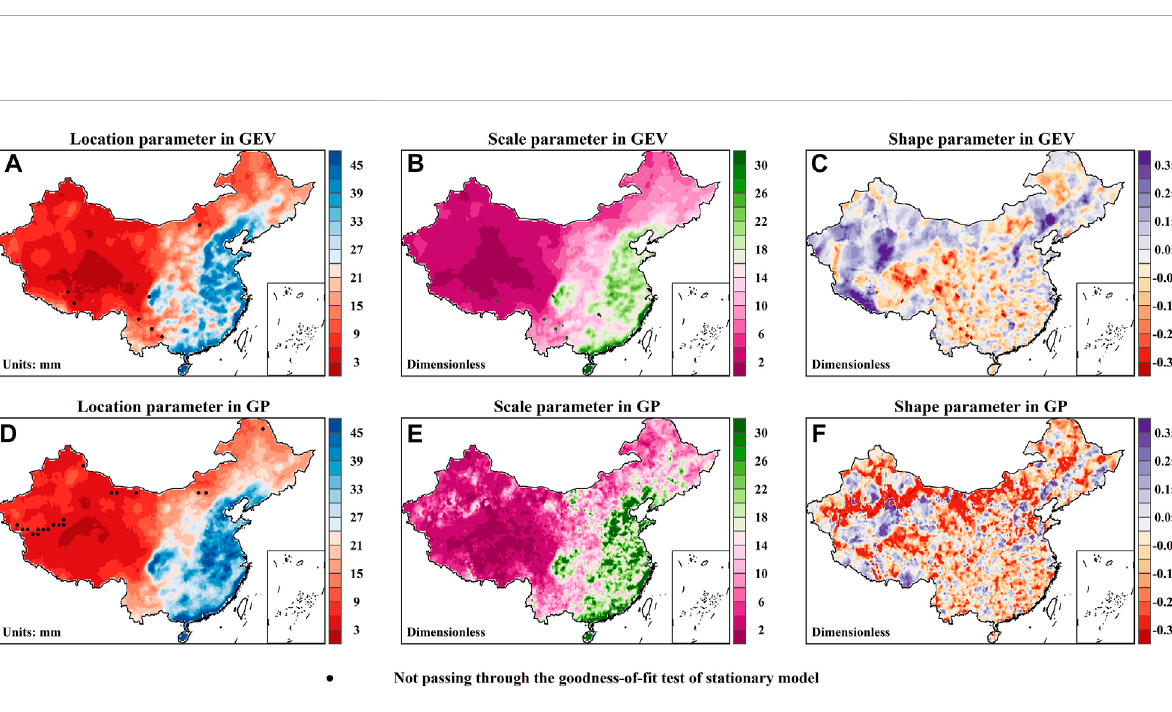
FIGURE 2 Spatial distributions of location, scale, and shape parameters in GEV distribution (A – C) and GP distribution (D – F) . The black dots in a and d indicatethatthetimeseriesofextremeprecipitationrejectthenullhypothesisat0.05signi fi cancelevel.Thenullhypothesisisthatthetimeseriescan be fi tted by the stationary GEV/GP